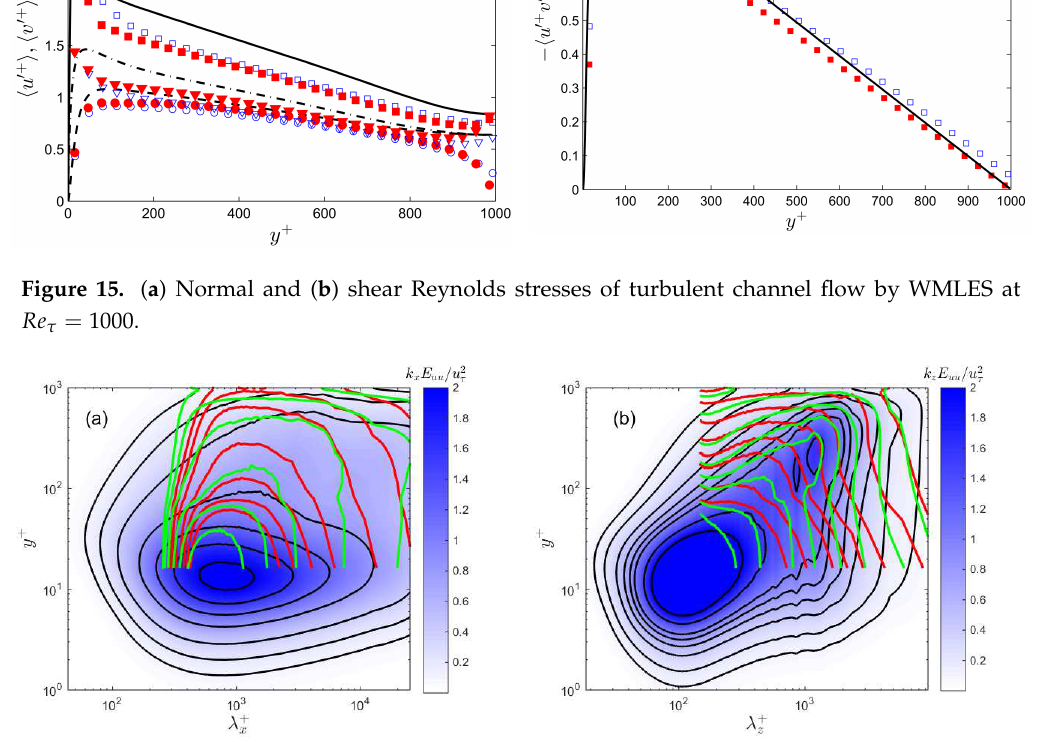
Figure 16. ( a ) Streamwise and ( b ) spanwise premultiplied spectrograms of streamwise velocity k x E uu / u 2 τ and k z E uu / u 2 τ of turbulent channel flow at Re τ = 1000. The black lines indicate spectrogram isolines of LM1000 by DNS, the red lines by the second-order central difference WMLES, and the green lines by the fourth-order compact difference WMLES. The contour line levels are 0.1, 0.2, 0.4, 0.6, 0.8, 1.0, 1.5 and